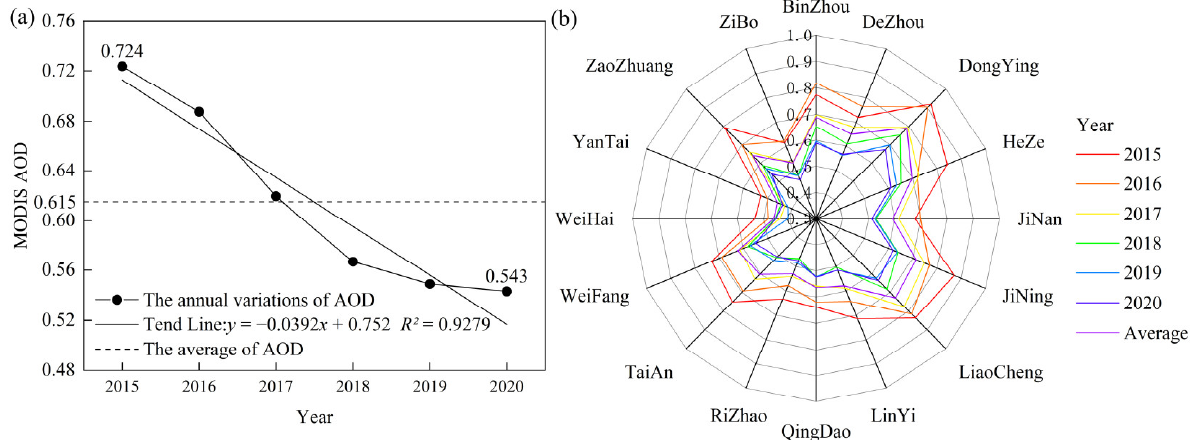
Figure 2. Variations of AOD in ( a ) Shandong Province and ( b ) prefecture-level cities from 2015 to 2020.